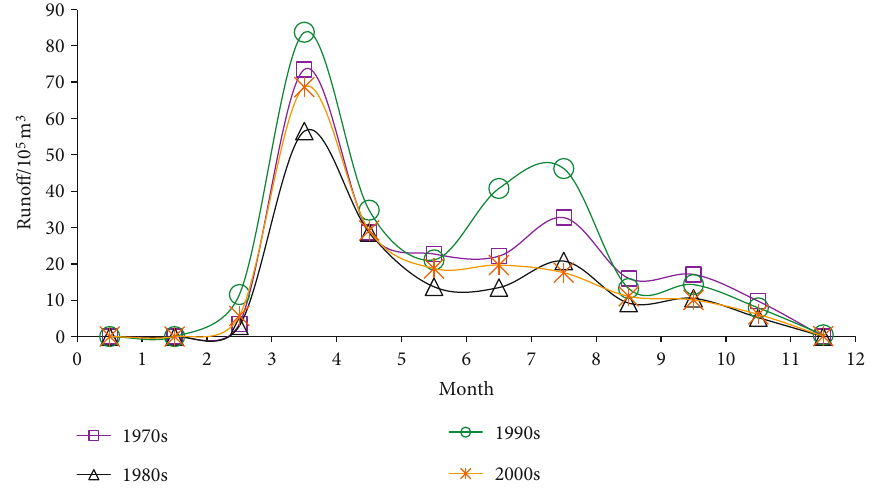
Figure 2: Month distribution characteristics in the years of runo ff in Xilinhe River. Table 1: Statistic characteristics of annual runo ff distribution in Xilinhe River.